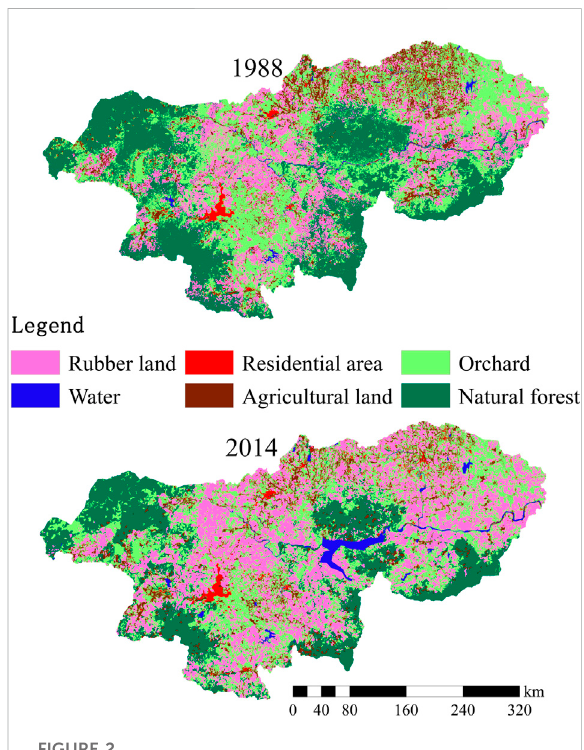
FIGURE 2 Land use of map of Wanquan River Basin in 1988 and